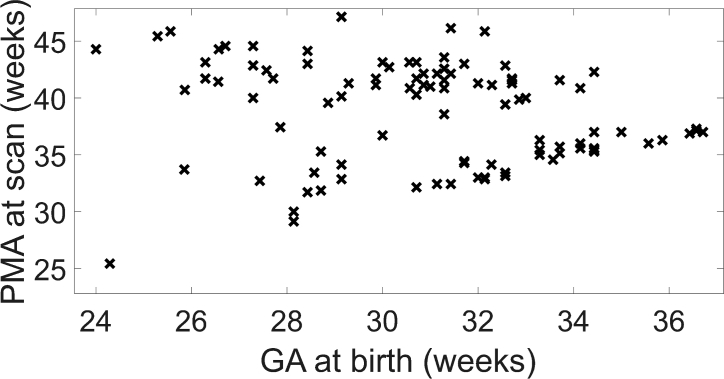
Distribution of postmenstrual age (PMA) at scan according to gestational age (GA) at birth.